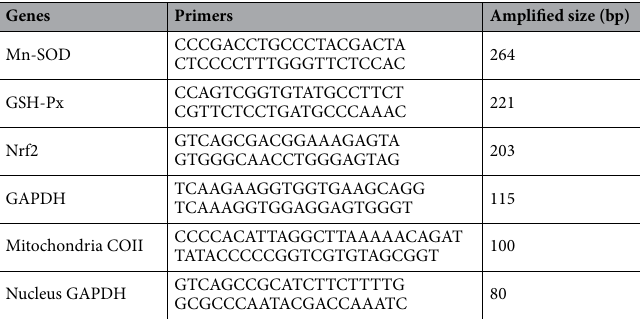
Mitochondria ultrastructure. Electron microscopy stationary liquid (G1102, Servicebio, China) was rap- idly added to the extracted ovarian GC sample. After 4 h of fixation at 4 °C, the cells were rinsed 3 times with phosphate buffer (pH7.4). Then, the GC sample was placed in 1% osmic acid, fixed at room temperature for 2 h, and rinsed with phosphate buffer (pH 7.4) 3 times. Next, the GC sample was dehydrated and embedded in ethyl alcohol and acetone at different concentrations. Afterwards, the GC sample was sliced into 50 nm ultrathin sec- tions using an ultrathin slicer (EM UC7, Leica) and stained with uranyl acetate and lead citrate. Finally, the GC mitochondria were observed using a transmission electron microscope (HT7700, Hitachi, Japan). Mitochondrial adenosine triphosphate (ATP). Mitochondrial ATP content was detected using an ATP detection kit (S0027, Beyotime Institute of Biotechnology, China). A total of 200 μl of lysate was added to each tube of ovarian GCs sample for centrifugation at 12,000 g for 5 min. The supernatant was removed for future use. The standard solution and test working solution were prepared according to the instructions. Then, the sample supernatant, standard solution, and test working solution were added to a 96-well plate according to the instruc- tions. The readings were made using Fusion FX5 Spectra (Vilber Lourmat, Marne-la-Vallée, France), and the concentrations were calculated according to the standard curve concentration. To boost accuracy, the protein concentrations of each group of samples were determined by a BCA protein concentration assay kit (PC0020, Solarbio, China), and the ATP content was converted to μmol/mg protein. ELISA of 8‑OHdG, Mn‑SOD, and GSH‑Px. The kits used for the detection of Mn-SOD and GSH-Px were purchased from Jiancheng Bioengineering Institute (Nanjing, China), and 8-OHdG was detected using 8-hydroxy-2 deoxyguanosine ELISA kits (ab201734, Abcam, USA). The ovarian GC sample lysis fluid was diluted to the optimal concentration to meet the standard curve for detection. The absorbance values were